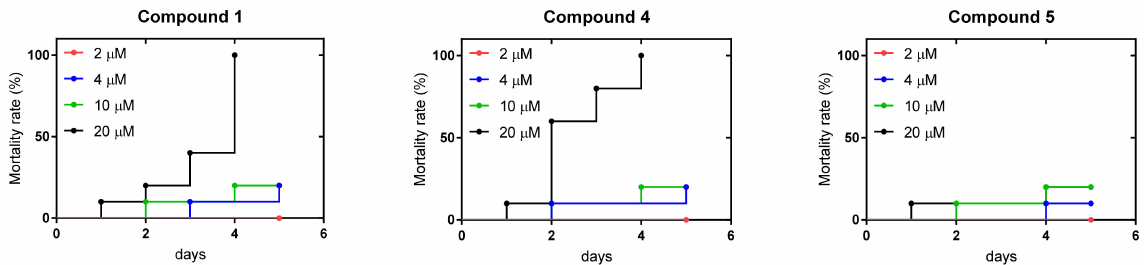
Figure 5. Mortality rates of selected compounds on zebrafish ( Danio rerio ) larvae. The population size ( n = 10) from Figure 4 was followed up to day 5 as described under Materials and Methods. Representative graphs are